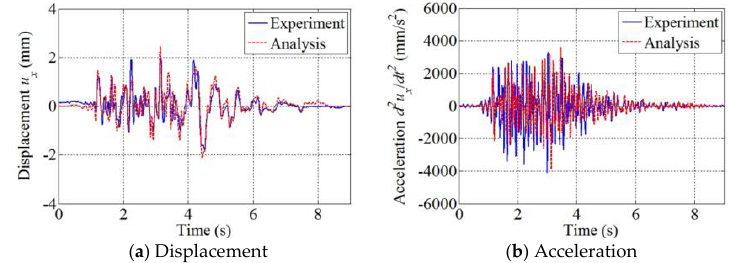
Figure 23. Numerical and experimental responses in the x direction due to the ground motion of Run 9; responses sampled at point A on the third floor.